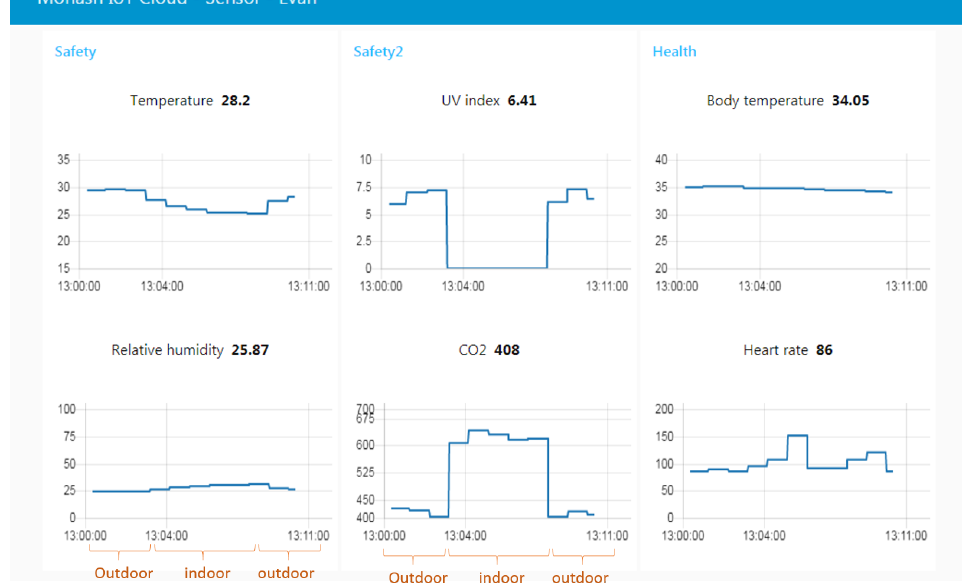
Figure 13. Website located on the IoT